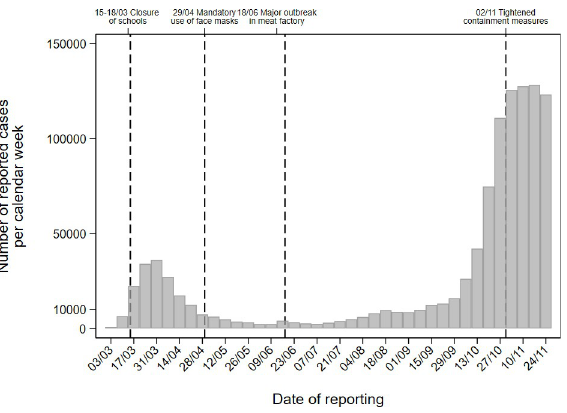
Fig 1. Number of COVID-19 cases reported to the Robert Koch Institute according to the onset of the disease, alternatively according to the reporting date [56].